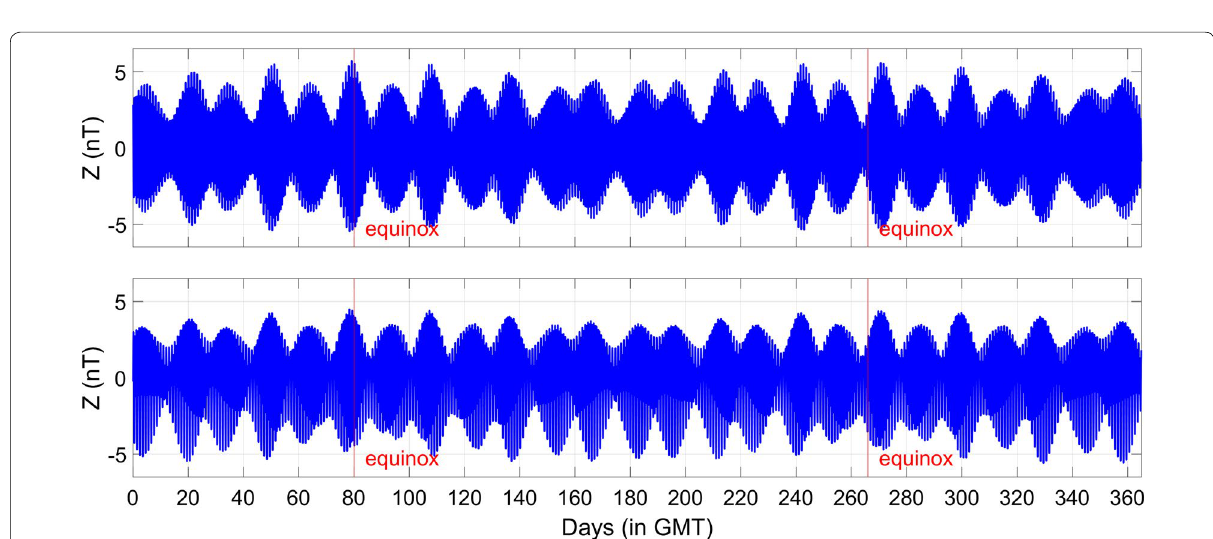
Fig. 16 Synthesized Z from a sum of eight tidal constituents (cf. Table 2) at VAL (upper panel) and T12-2 (lower panel) for the year